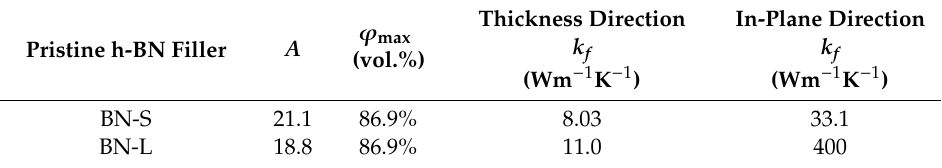
Table 4. Lewis-Nielsen model parameters of the plots shown in Figure 11. BN-S and BN-L refer to the hexagonal boron nitride (h-BN) platelets of the size of 8 and 18 µ m, respectively, see Reference